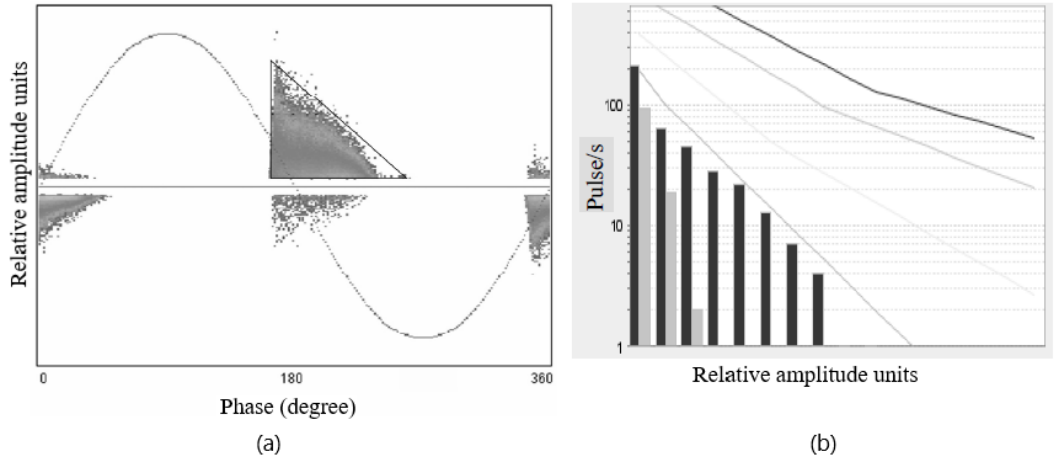
Figure 8. ( a ) PRPD pattern, ( b ) 2D equivalent [20,33].